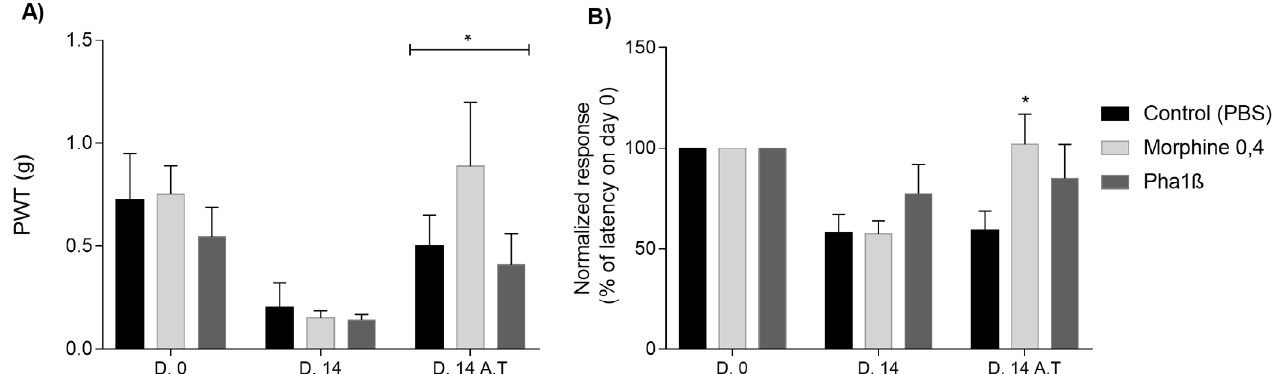
Figure 3. Antinociceptive effect of morphine and recombinant Phα1β on mechanical and thermal hyperalgesia in mice with melanoma. Day 0 (D.0) represents the measurements immediately before B16-F10 cell inoculation. Day 14 (D.14) shows data on the inoculation of B16-F10 cells at the right hind paw, which induces a reduction on both (A) paw withdraw threshold (PWT) and in (B) the withdrawal latency for a thermal stimulus indicating mechanical and thermal hyperalgesia, respectively. Fourteen days after B16-F10 inoculation (D.14 after treatment – A.T.), the treatment with morphine (0.4 nmol/site, intrathecal) or recombinant Phα1β (30 pmol/site, intrathecal) significantly reverses the mechanical hyperalgesia whereas only morphine was able to reverse thermal hyperalgesia. Data are reported as mean ± S.E.M. *p < 0.05 compared to data on D.14 (ANOVA with repeated measures), data are expressed as mean ± SEM (n = 8-10 animals per